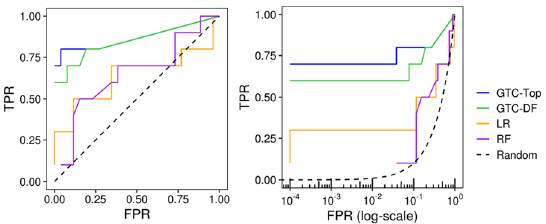
Fig 2 (abstract 000205). ROC curves. FPR in (b) is log scaled to emphasize performance at low FPR settings.